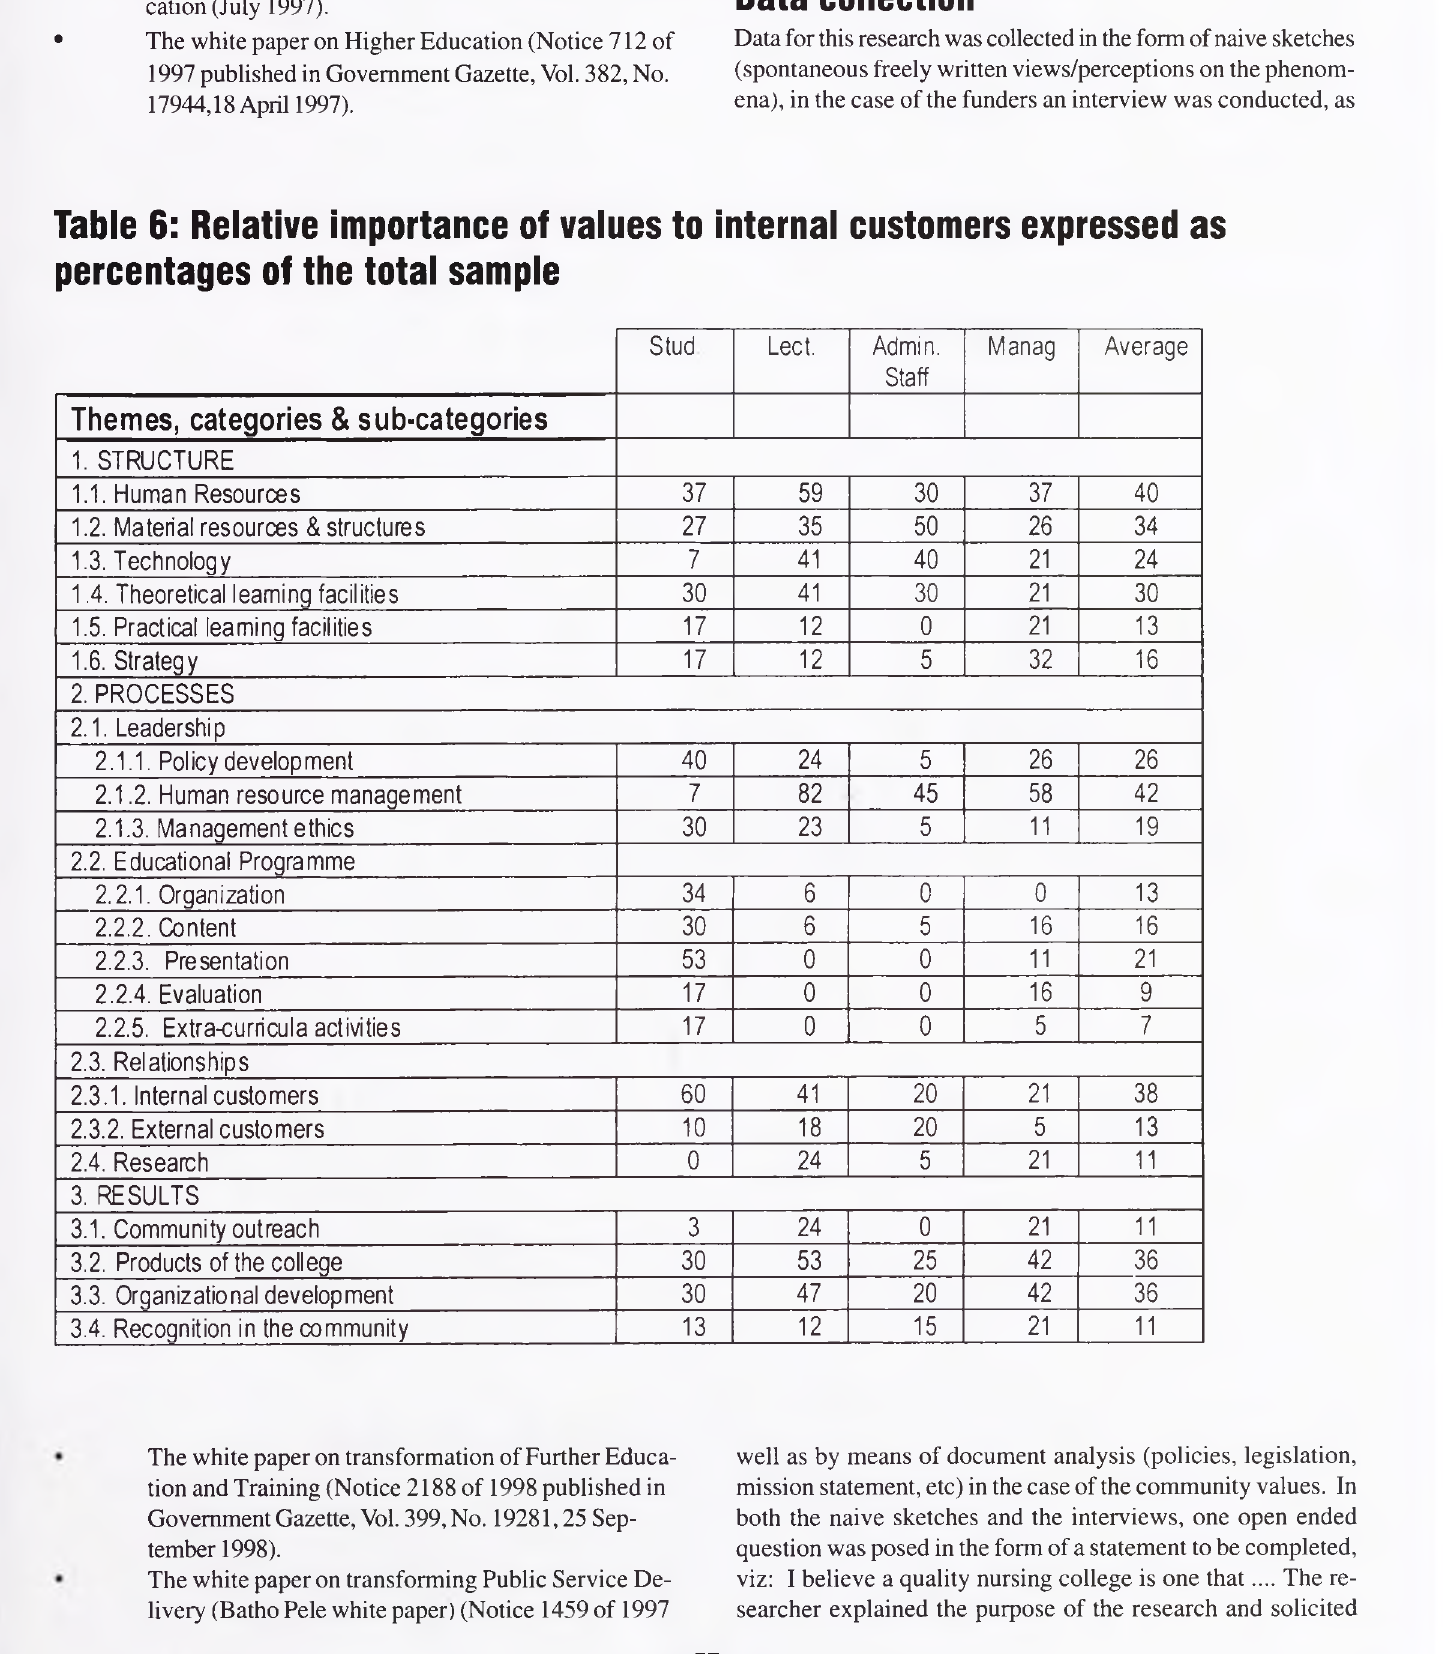
Table 6: Relative importance of values to internal customers expressed as percentages of the total sample